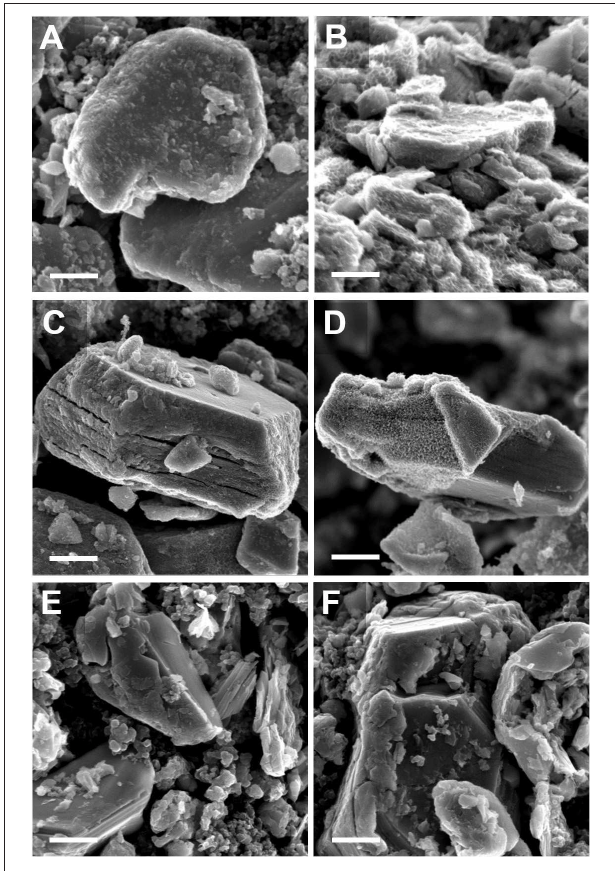
FIGURE 7 | SEM images of (A,B) F.E., (C,D) P.E., and (E,F) P2 NaMCu electrodes after 600 cycles in 0.5M K 2 SO 4 . While most F.E. particles show expansion or a surface coating, few P.E. particles show surface coating, and few P2 particles even show expansion. Scale bar 500nm.